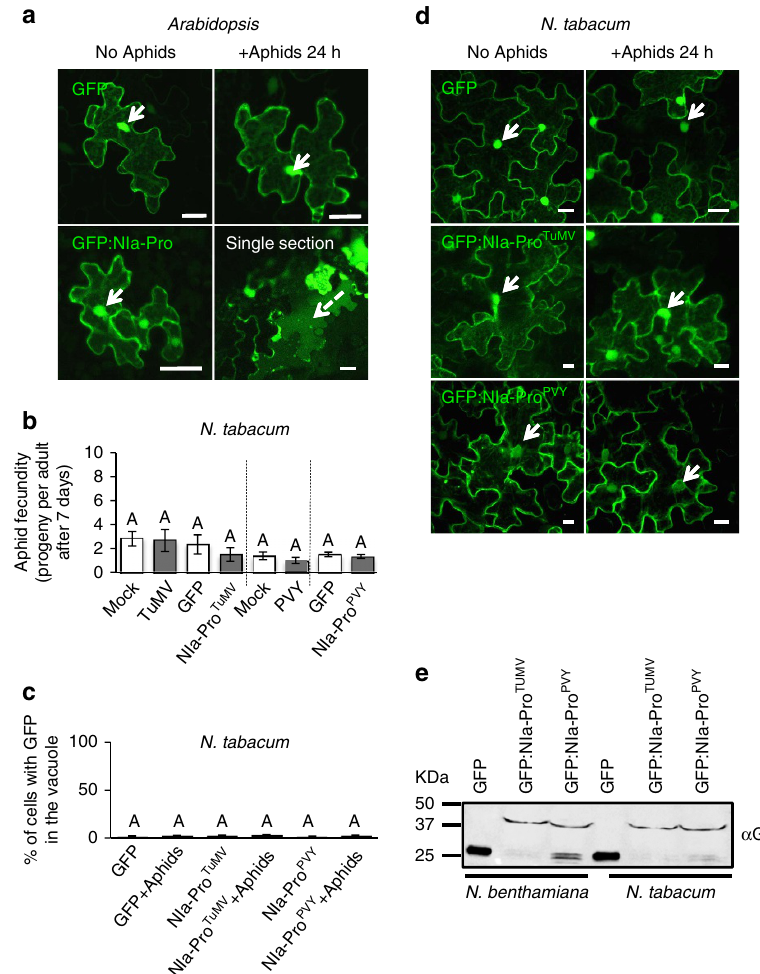
Figure 7 | NIa-Pro relocalization and impact on aphid fecundity is host plant dependent. ( a ) Images show confocal projections and a single section of transgenic A. thaliana leaves expressing free GFP or GFP:NIa-Pro with or without aphids present. ( b ) Number of progeny produced by aphids on healthy N. tabacum or on N. tabacum plants inoculated or agroinfiltrated with free GFP, TuMV, PVY, GFP:NIa-Pro TuMV or GFP:NIa-Pro PVY . ( c ) The percentage of cells with GFP in the vacuole for N. tabacum plants expressing free GFP, GFP:NIa-Pro TuMV and GFP:NIa-Pro PVY with or without aphids. ( d ) Images show confocal projections from c . GFP localizes to the nucleus but does not localize to the vacuole during aphid presence in N. tabacum plants. ( e ) The image represents a western blot made with leaf extracts from N. benthamiana or N. tabacum leaves agroinfiltrated with free GFP, GFP:NIa-Pro TuMV and GFP:NIa-Pro PVY , and incubated with an GFP antibody. We can see that the expression of free GFP, GFP:NIa-Pro TuMV and GFP:NIa-Pro PVY is similar in the different hosts. Mean ± s.e. of N ¼ 6 for a , c , d and N ¼ 8–12 for b ; letters represent significant differences, ANOVA and Tukey’s honest significant difference post hoc , P o 0.05. Results from one out of two independent experiments are displayed in a and from three independent experiments in c . Dashed arrow indicates the vacuole and white arrows indicate the nucleus. Scale bars, 20 m